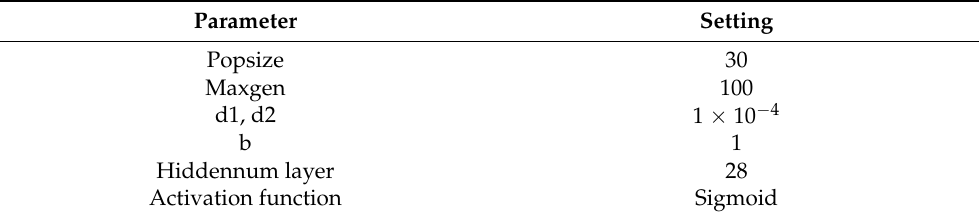
Table 2. Parameter settings for the MWOA-ELM